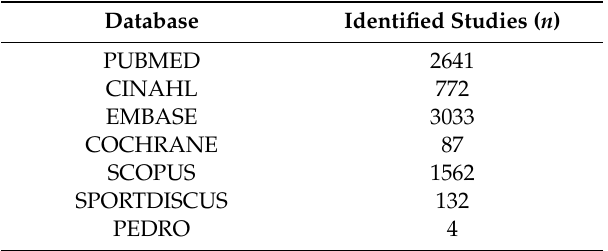
Table 3. Databases and search results prior to screening and removal of